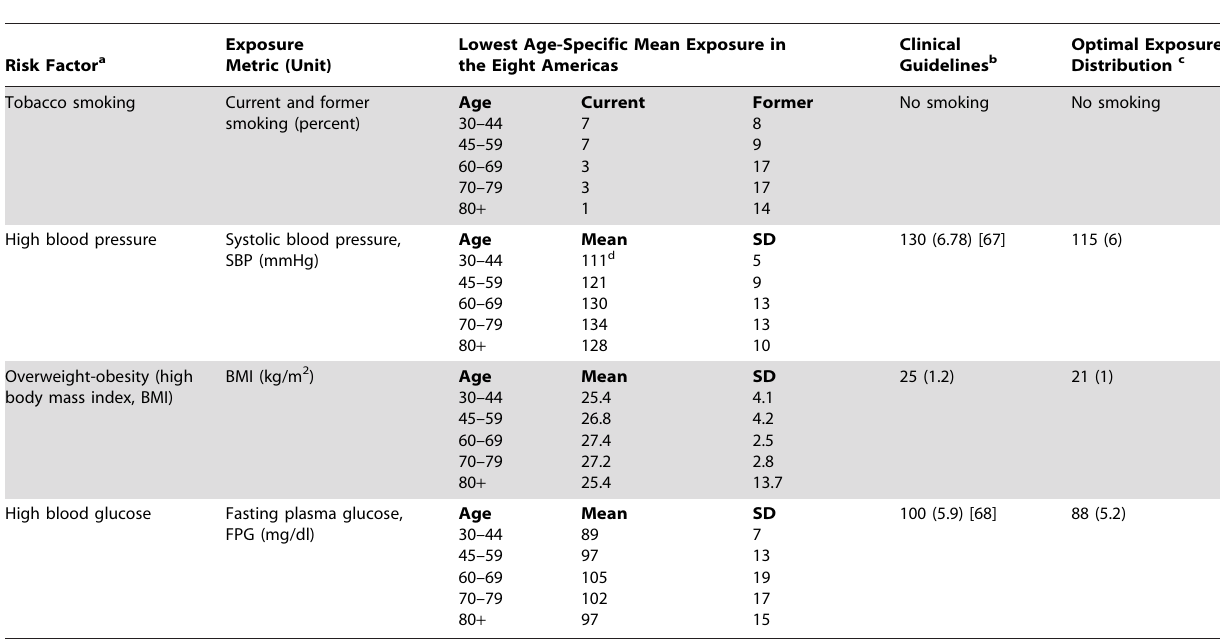
Table 2. Risk factors in this analysis, their exposure metric, lowest observed mean in the Eight Americas, clinical guidelines, and optimal